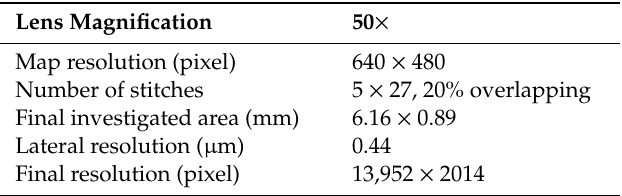
Table 1. Measurement conditions (Zygo NewView 7300) for each sample.